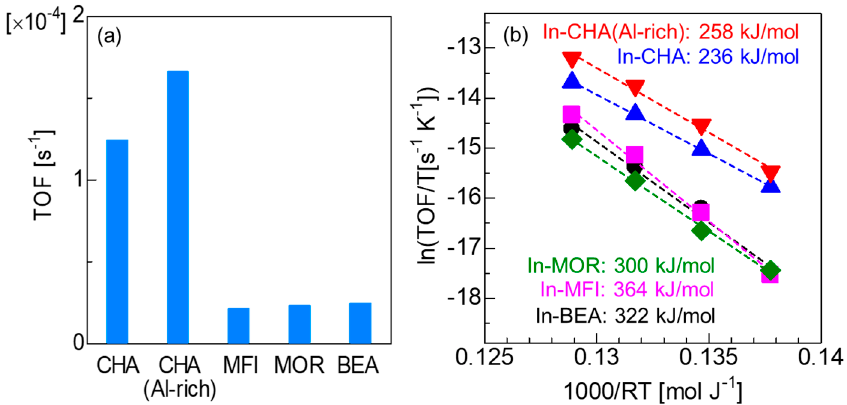
Figure 5. ( a ) Effect of zeolite host on turnover frequency (TOF) normalized to amount of In obtained at 873 K. ( b ) Eyring plots and apparent activation enthalpies for the ethane dehydrogenation (873 − 933 K) using In-MFI (pink), In-MOR (green), In-BEA (black), and In-CHA(Al-rich) (red). The plots were obtained under conditions obtaining ethane conversions below 15%. The data for In-CHA (blue) were previously reported in our previous paper [56].